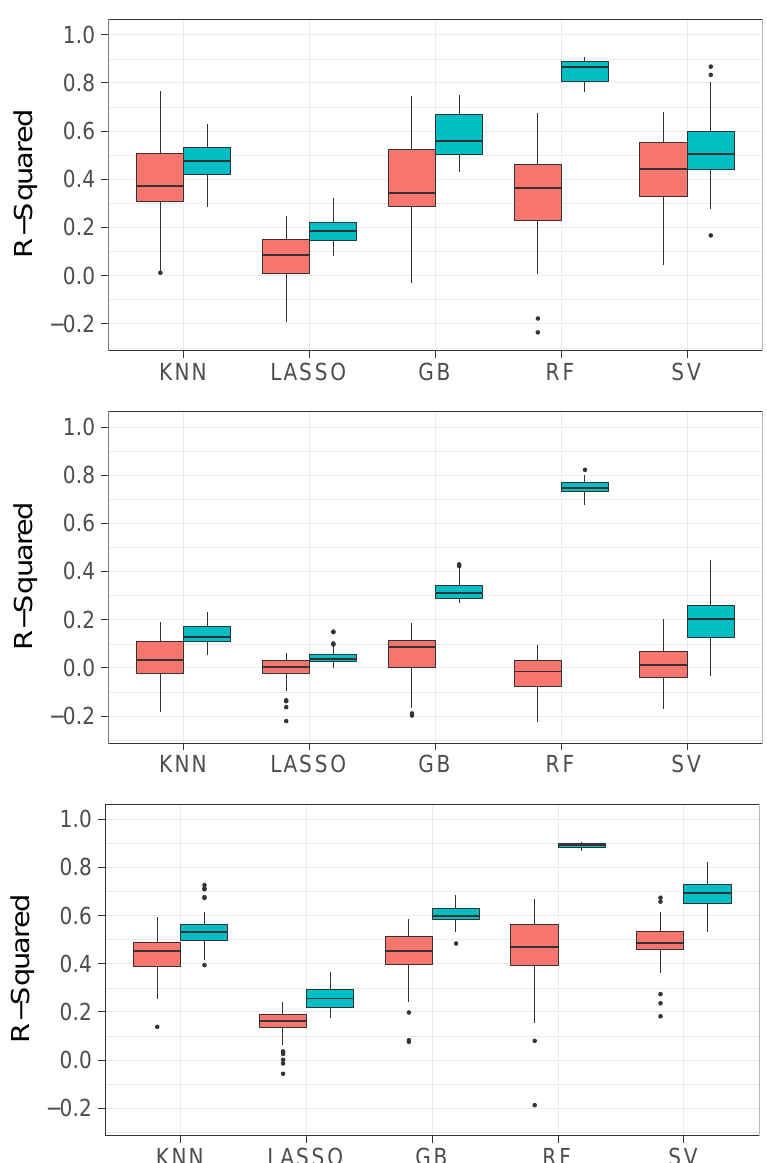
Figure A1. Boxplots of the training (green) and test (coral) R 2 from 50 iterations of each machine learning method applied to the 74 MISR mixtures for predicting PM 2.5 ( top ), PM 10 ( middle ) and SO 2 ( bottom